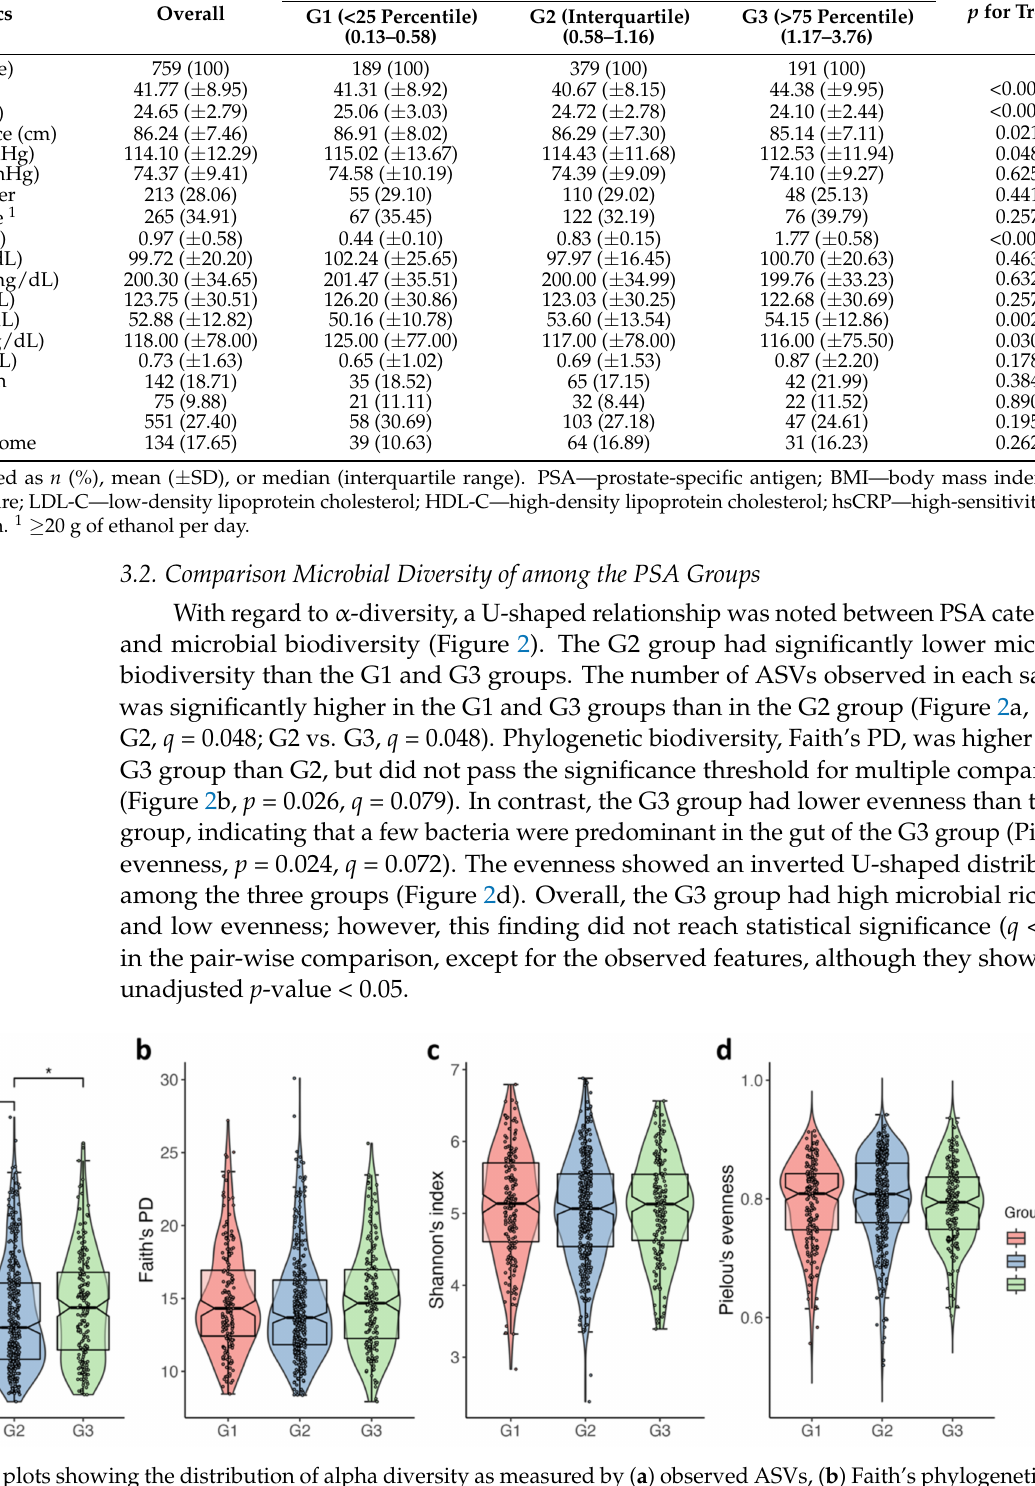
Figure 2. Violin plots showing the distribution of alpha diversity as measured by ( a ) observed ASVs, ( b ) Faith’s phylogenetic diversity (PD), ( c ) Shannon’s index, and ( d ) Pielou’s evenness, among the PSA groups. Statistics were calculated using a pair-wise Kruskal–Wallis test. * q < 0.05. The notched boxes indicate the interquartile range (IQR) of the 25th to 75th percentiles. The median value is shown as a line within the box, and the whiskers extend to the most extreme value within 1.5 × IQR. Each point represents an individual